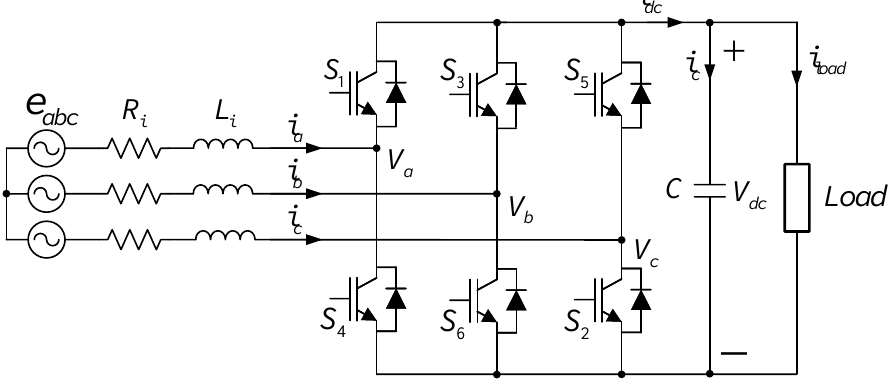
Figure 1. Configuration of 3-phase alternating current/direct current (AC/DC) pulse width modulation (PWM) converter.